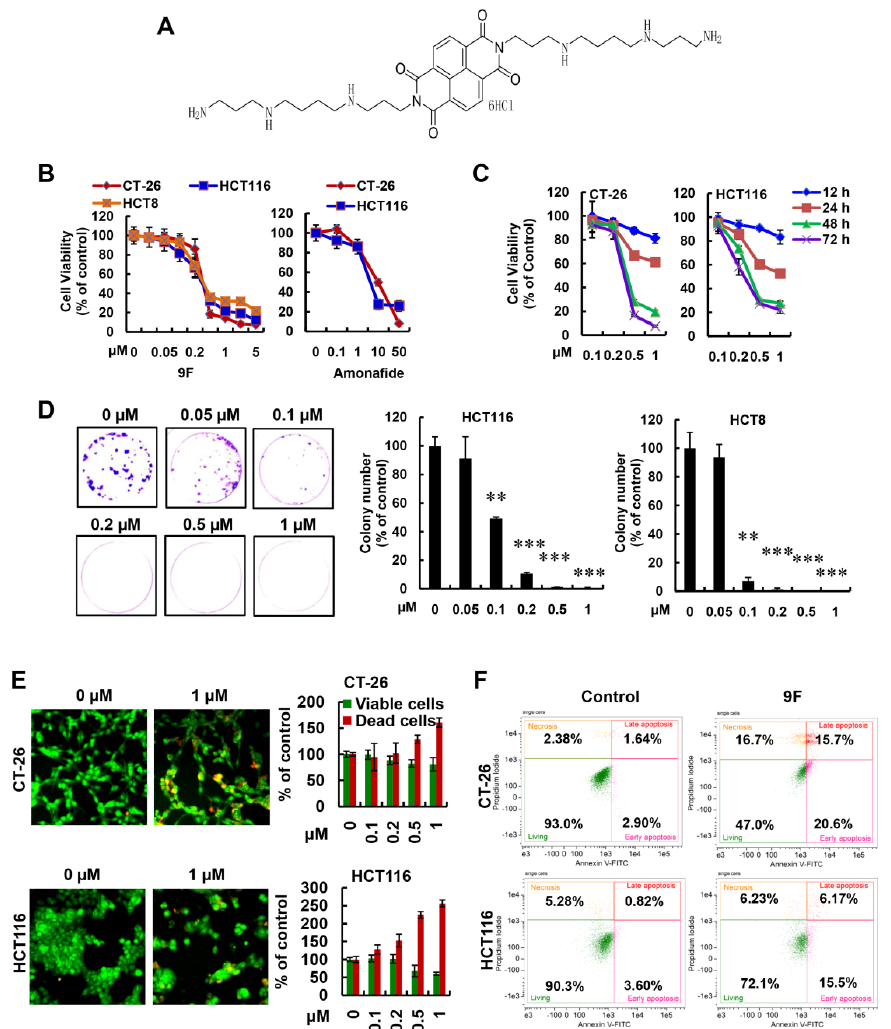
Figure 1. 9F inhibited cell growth and induced cell death of colorectal cancer (CRC) cells. ( A ) The chemical structure of 9F. ( B ) Cell viability was measured in CRC cells treated with various concentrations of 9F and amonafide for 48 h. ( C ) Cell viability was measured in CRC cells treated with various concentrations of 9F for 24h, 48 h and 72 h. ( D ) Representative images (HCT116 cells) and statistics results of colony formation assay in CRC cells. CRC cells were treated with 9F at different concentrations for 7 days. ** p < 0.01, and *** p < 0.001. ( E ) AO/EB staining was used to detect cell death of CRC cells exposed to 9F for 48 h (20×). ( F ) CT-26 cells and HCT116 cells were treated with 9F (1 µ M) for 48 h. Cell death was detected using flow